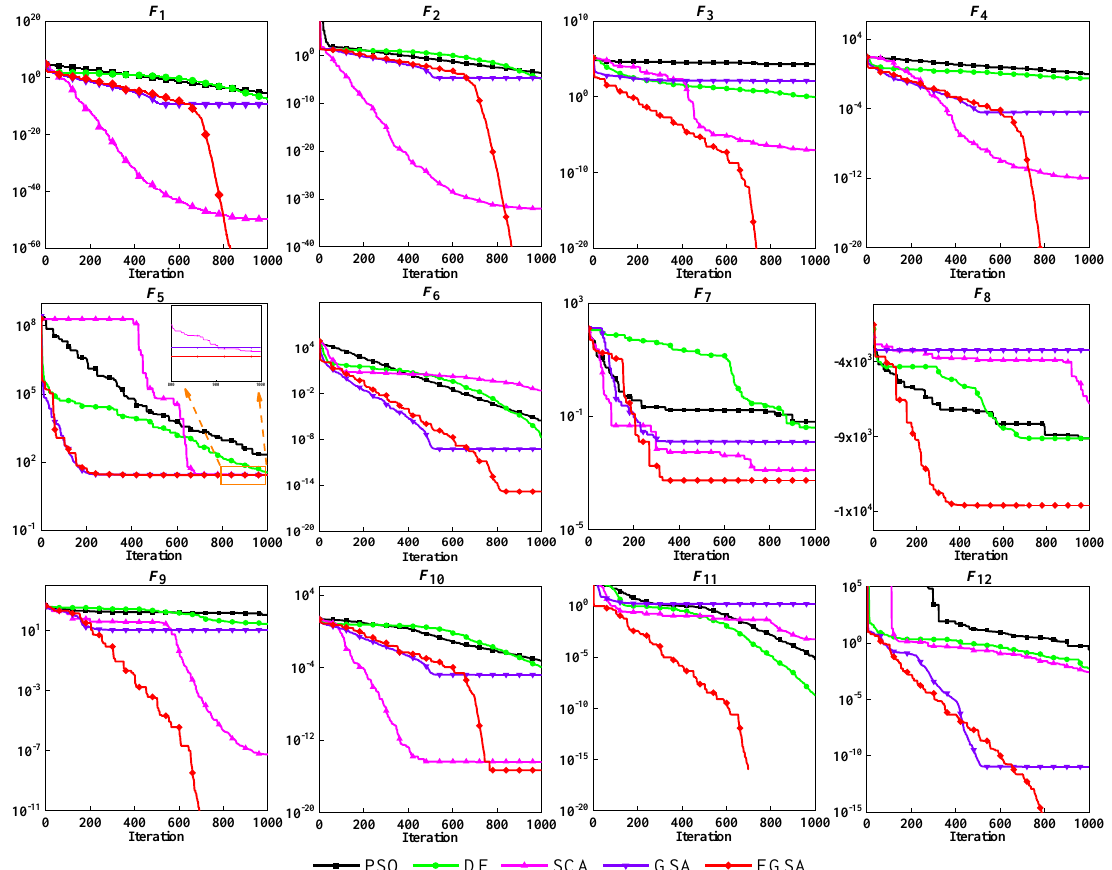
Figure3. Convergencetrajectories of the di ff erentmethods for 12 benchmark functions with 30